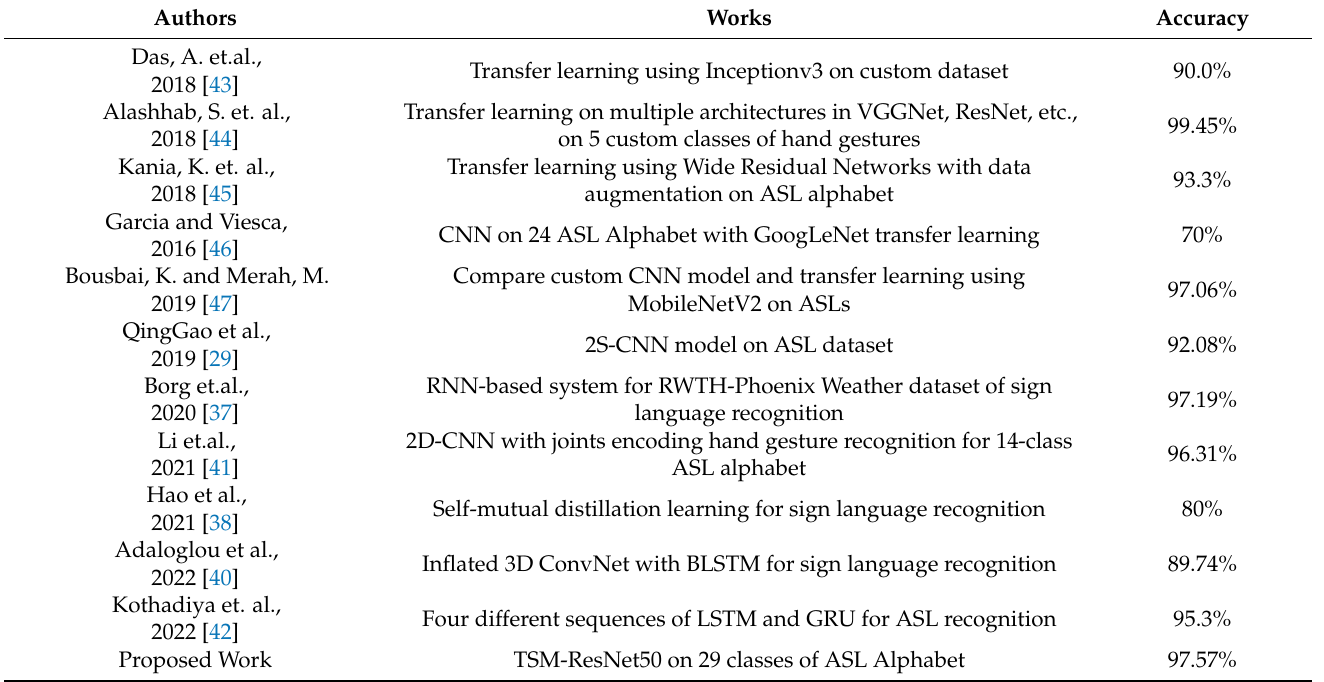
Table 8. Comparison of Our Work with Previous